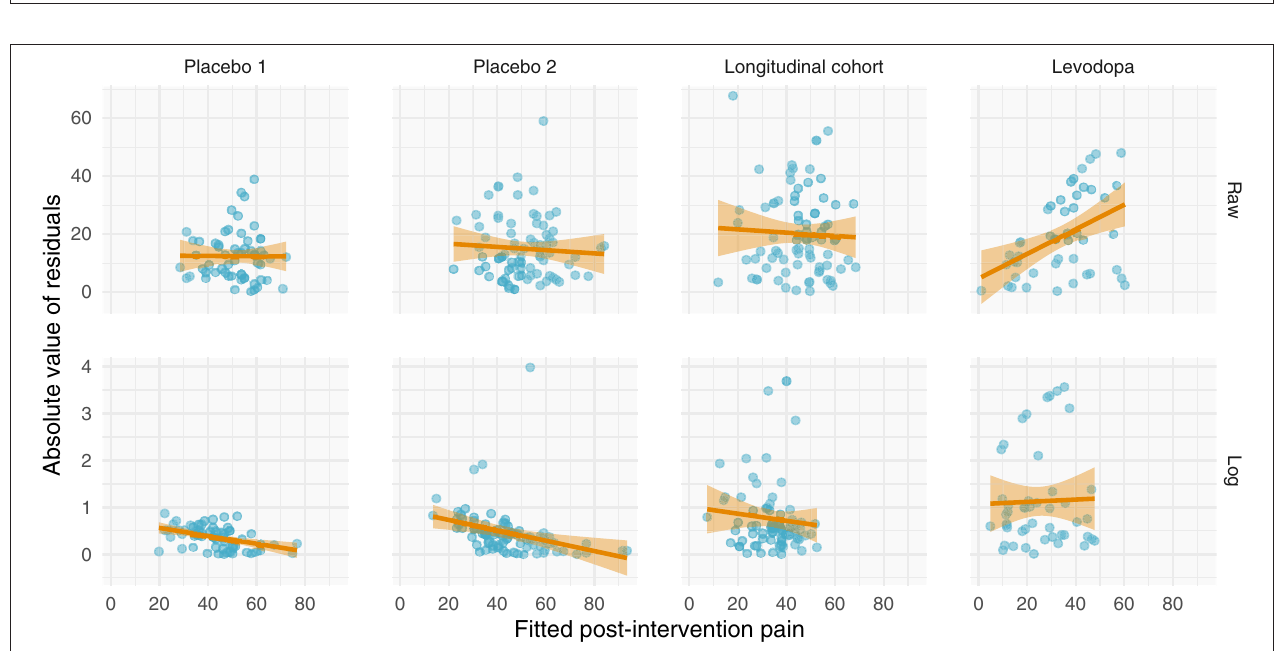
FIGURE 6 | Increasing the number of points used for each patient’s pre- and post-intervention scores increases the slope between change scores and pre-intervention scores. Each patient’s pre- and post-intervention scores were calculated using the mean of x points. By averaging over more points, we should increase the intraclass correlation coefficient. Negative slopes between change scores and pre-intervention scores are indicative of one of two things: (1) regression toward the mean or (2) multiplicative effects. In the datasets that show evidence of being additive, we see marked increases in slopes, indicating that we are decreasing regression toward the mean by including more points. However, because the Levodopa Trial displays multiplicative properties, it is only minimally affected by adding more points.